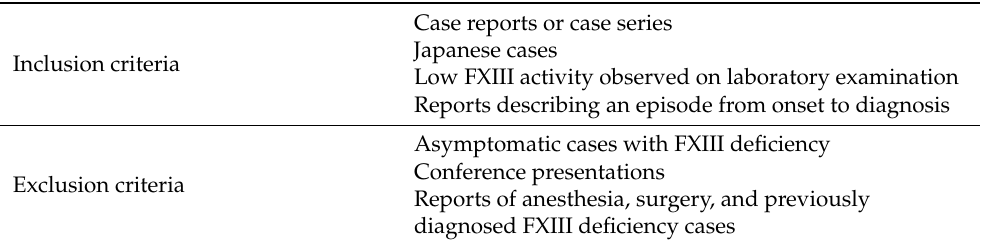
Table 2. Study inclusion and exclusion